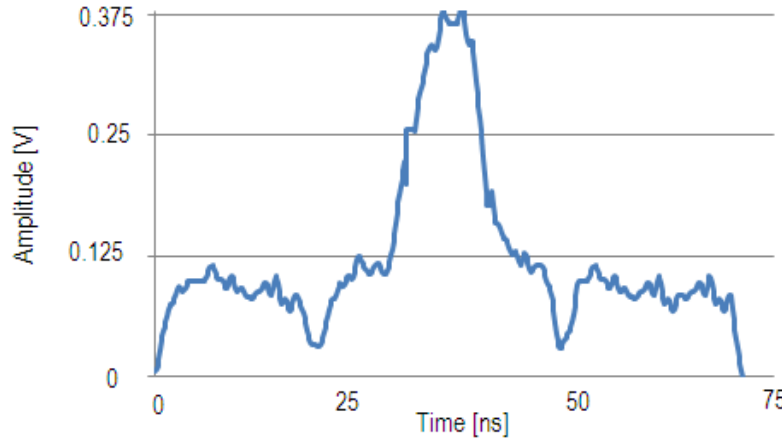
Figure 4. Correlation output with matched input signal 1011.